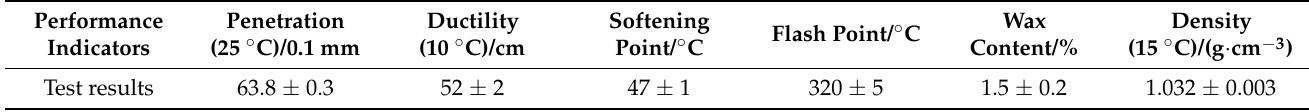
Table 1. Technical indexes of base asphalt.